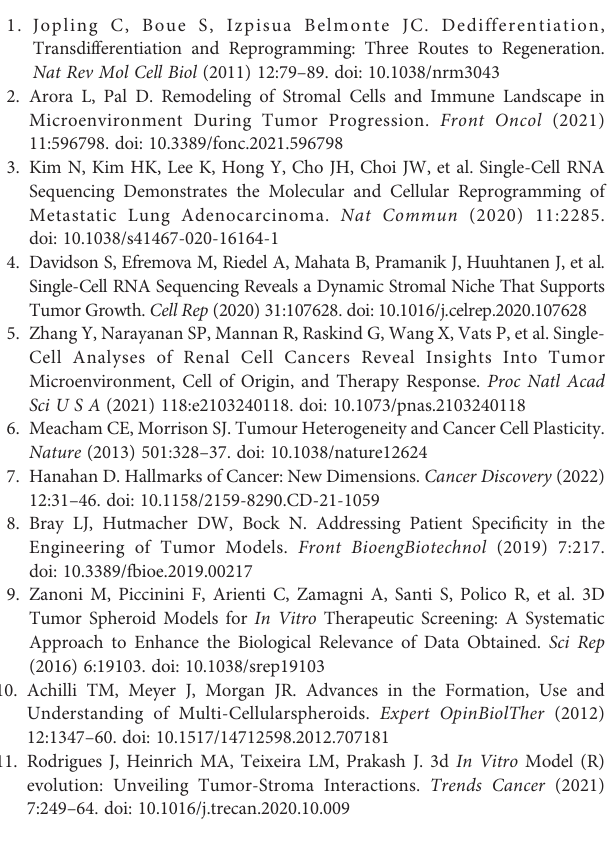
Supplementary Figure 1 | Optimization of theprotocol for spheroid development usingdifferentcellconcentrationsi.e.5,000,8,000and10,000perdropusingmodi fi ed